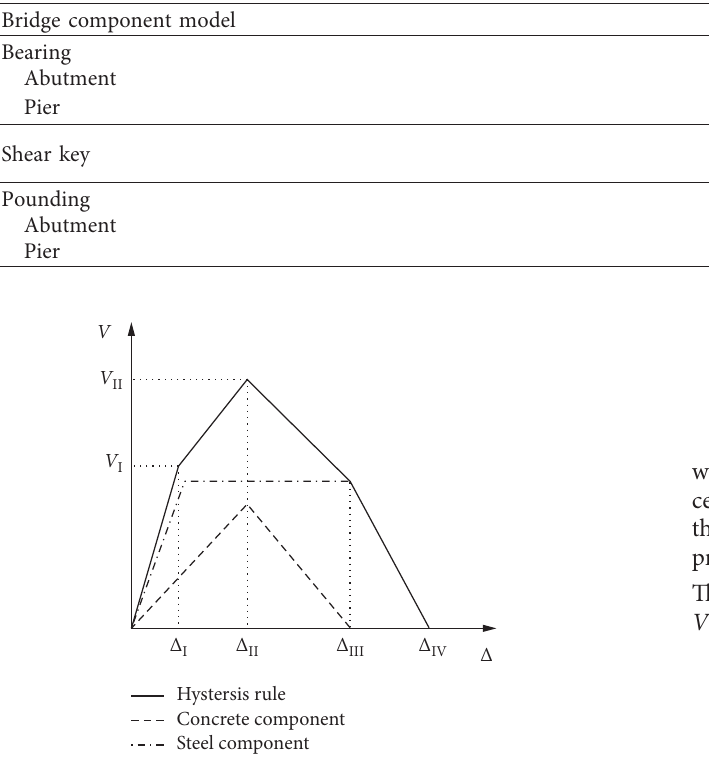
Figure 3: Analytical models of shear